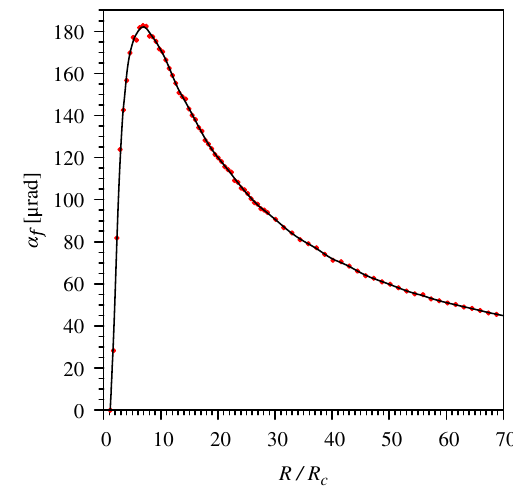
Fig. 3 The dependence of the maximum deflection angle α f on which the given fraction f = 0 . 1 of beam particles can be deflected by a bent crystal on the radius of curvature of the crystal